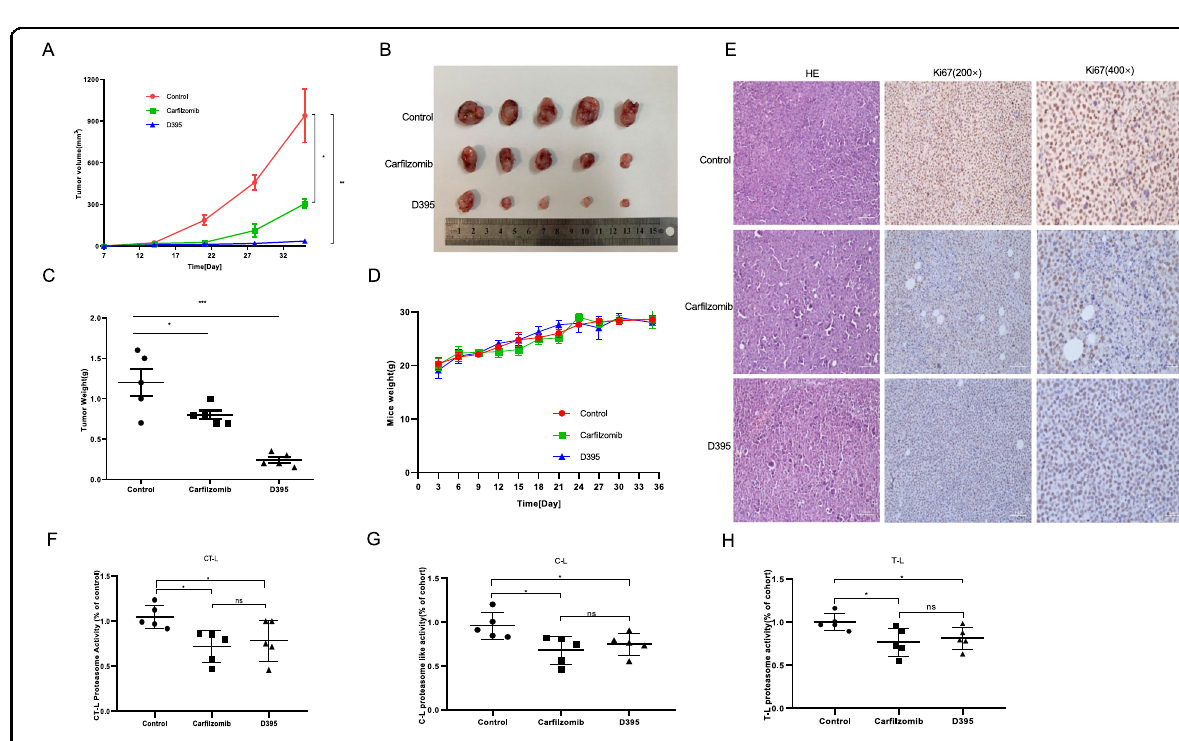
Fig. 5 Effects of D395 on the growth of ARP1 xenografts established in nude mice. A – C ARP1 cells (1 × 10 6 cells per mouse) were subcutaneously injected into BALB/c nude mice. After 4 days, the mice were randomly divided into 3 groups for different therapies (control group: PBS, i.v. 100 μ l/mouse; car fi lzomib group: car fi lzomib, i.v. 4 mg/kg; D395 group: D395, i.v. 4 mg/kg). All the mice were sacri fi ced at day 35. Tumor volume and weight were recorded. D Mice body weight was measured every 3 days. Data are shown as the mean ± SD. E The obtained tumor samples were dissociated for immunohistochemistry and stained for Ki67 (scale bar = 50 μ m). F – H Proteasome CT-L, C-L, and T-L activities in tumors from control group, car fi lzomib group and D395 group were